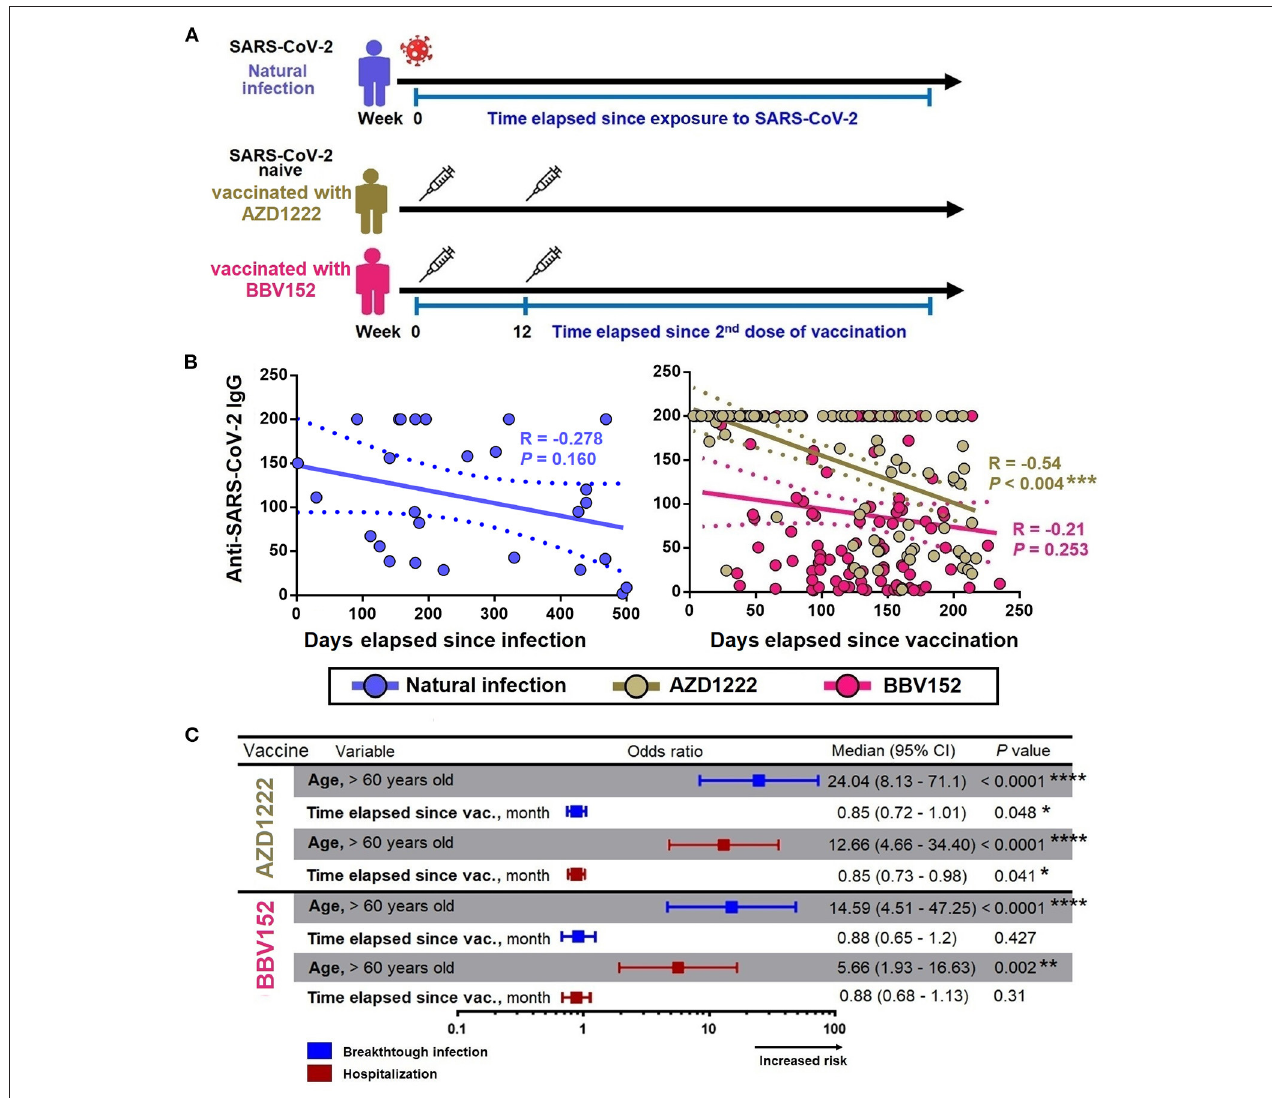
FIGURE 3 | Factors associated with decay of anti-SARS-CoV-2 S1 IgG. (A) Anti-SARS-CoV-2 S1 IgG decay cohort design. (B) Spearman correlation between the levels of anti-SARS-CoV-2 S1 IgG with the time elapsed since exposure to infection/vaccine administration. (C) Binary regression models assessing the association between age ( > 60 years) and time elapsed since vaccination with breakthrough infection and hospitalization. Odds ratios were displayed in a forest plot; median and 95% CI were calculated. CI, confidence interval; month define as 30 days. *, **, ***, *** represent P < 0.05, < 0.01, < 0.001, < 0.0001,